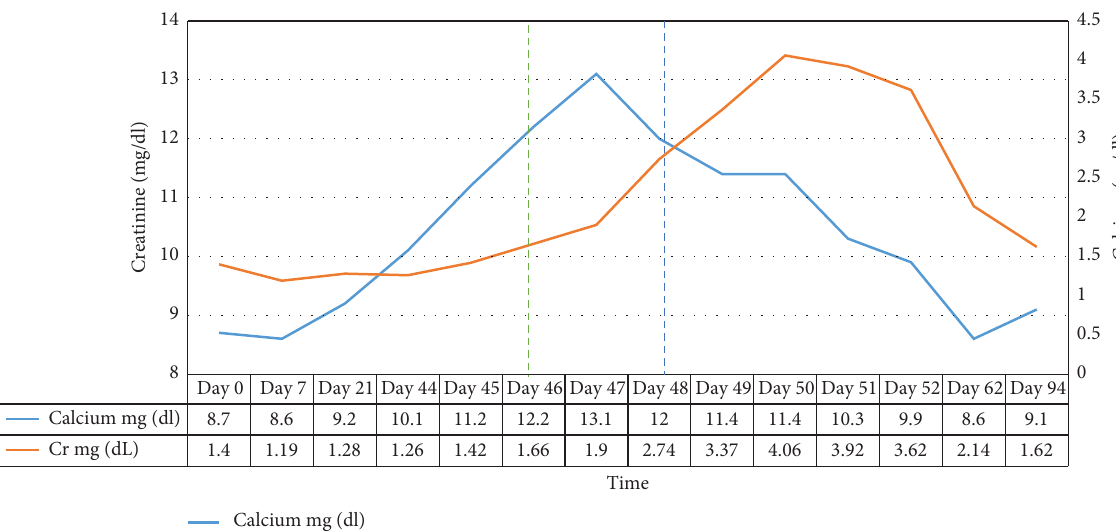
Figure 1: Tis graph shows the trend in the levels of calcium and creatinine throughout the patient’s hospitalization as various treatments were provided as labeled above. “Day 0” is one day prior to pembrolizumab administration. “Day 94” represents post hospitalization recheck of laboratory studies. Te X axis represents time measured in days. Te left Y axis illustrates creatinine levels in mg/dL. Te right Y axis demonstrates the calcium levels in mg/dL. Te green dashed lines indicate the start dates for denosumab and the blue dash vertical dash lines indicate the start dates for